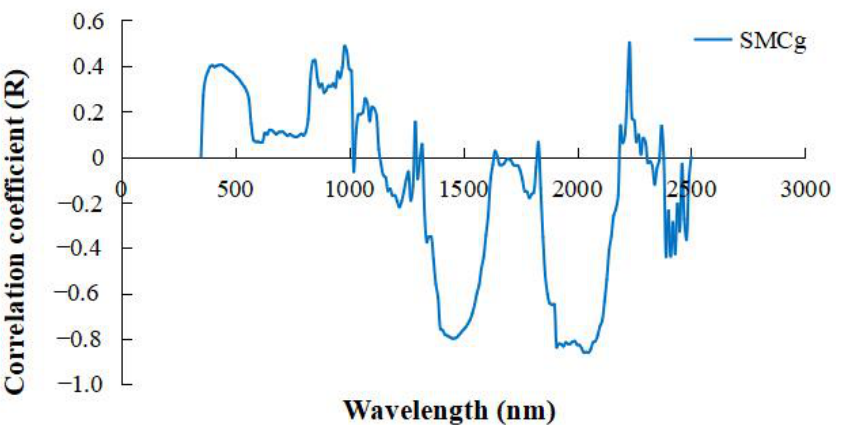
Figure 6. Correlation coefficients between the SMC g and its continuum-removal reflectance.